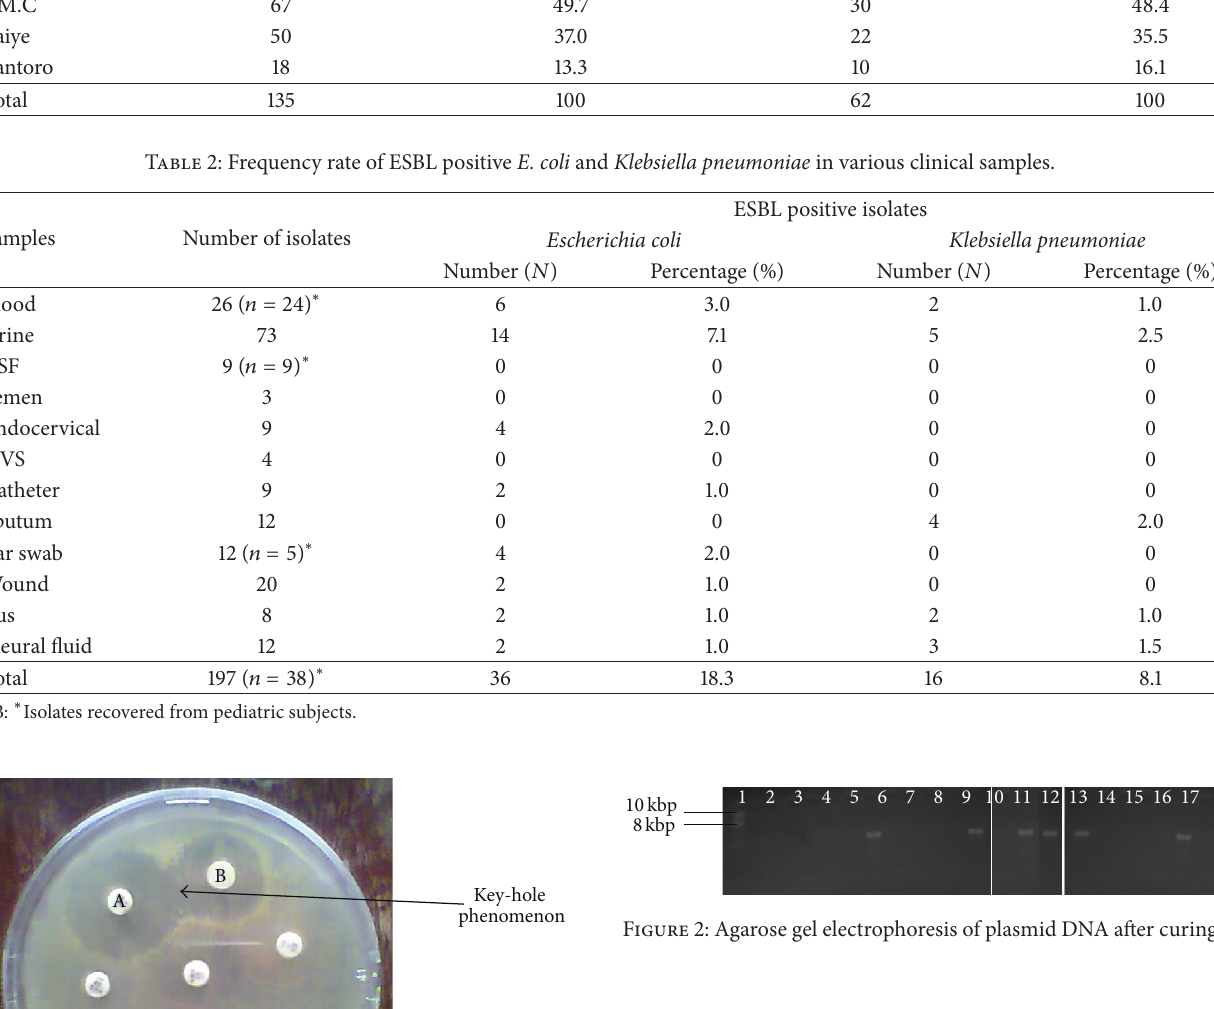
(49.7%) was obtained from Federal Medical Centre, Idi- Aba, while (37.0%) and (13.3%) were obtained from State hospital Ijaye and Sacred heart hospital Lantoro respectively. Total of 30 (48.4%) of the Klebsiella pneumoniae isolated were obtained from Federal Medical Centre, Idi-Aba, and 22 (35.5%) from State Hospital Ijaiye while 10 (16.1%) were obtained from Sacred Heart Hospital